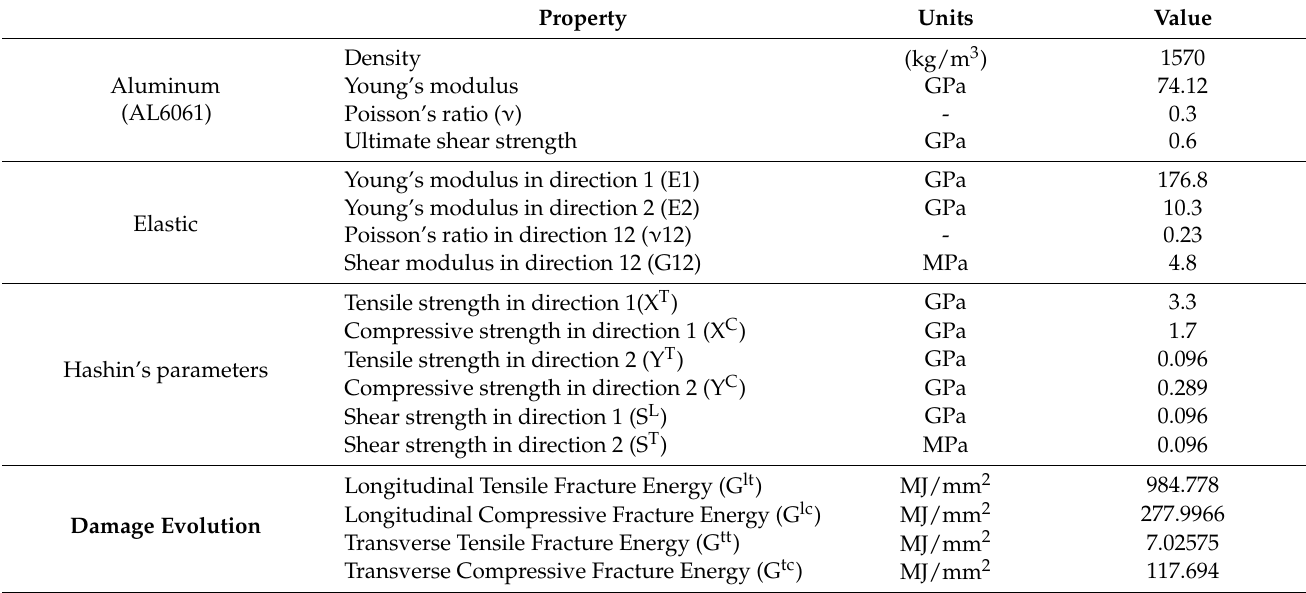
Table 1. Physical property values of Aluminum linear and CFRP (T800S and TCRUF